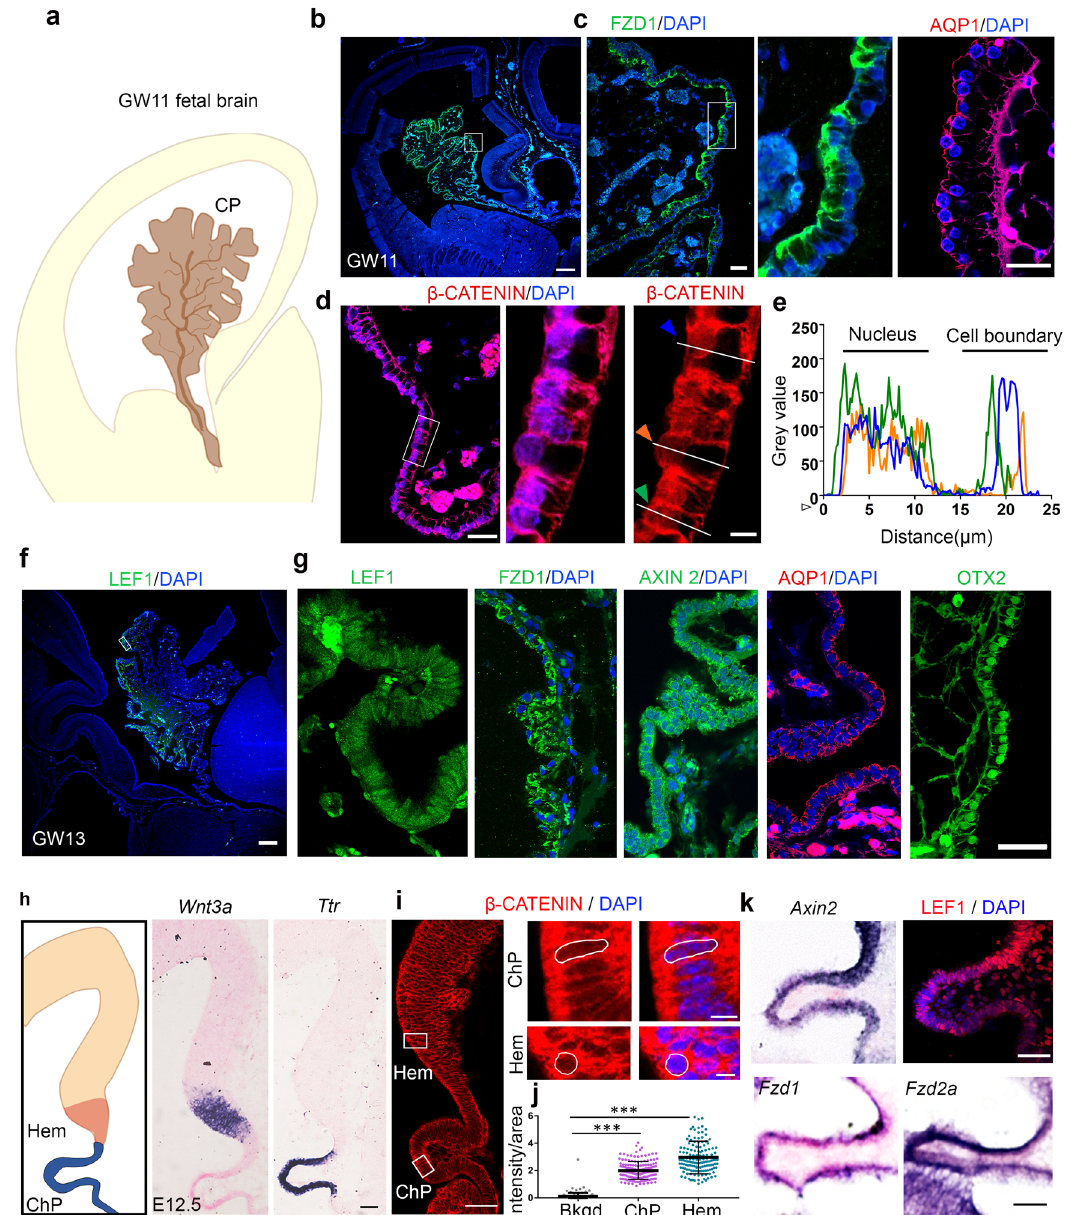
Fig. 1 Canonical Wnt signaling components are present in the developing human and mouse choroid plexus epithelium. a – g Canonical Wnt signaling pathway molecules FZD1, β -CATENIN, LEF1, and AXIN2, and also ChPe markers OTX2 and AQP1 are detected at gestational week (GW) 11 ( b – e ) and GW13 ( f , g ) in the human choroid plexus epithelium. d , e β -CATENIN immunohistochemistry intensity measurements across three ChPe cells (identi fi ed by colored arrowheads in d corresponding to traces in e ). β -CATENIN intensity is seen in the nucleus, indicative of active canonical Wnt signaling and the boundaries between cells. b – g Representative images of sections taken from 1 fetal brain at each age. h In the E12.5 mouse telencephalon, Wnt3a and Ttr expression identi fi es the hem the ChPe, respectively. i , j Nuclear localization of β -CATENIN and its quantitation (Bkgd, background; scatterplot represents mean ± SEM; n = 150 nuclei; N = 3 brains (biologically independent replicates) examined over 3 independent experiments. k Canonical Wnt signaling components Axin2, Fzd1, Fzd2a , and LEF1 are expressed in the E12.5 mouse ChPe. ( h , k ) Representative images of sections taken from N = 7 brains (biologically independent replicates) examined in 5 independent experiments. Statistical test ( j ): One Way ANOVA followed by post hoc Dunnett ’ s multiple comparison test ( p < 0.0001), * p < 0.05, ** p < 0.01, *** p < 0.001, ns if p value > 0.05. Scale bars: 500 μ m (all panels in b and f ); 50 μ m (all panels in d , i low mag, g , h , and k ); 10 μ m ( d and i high mag). Boxed regions ( b , c , d , f , i ) are shown at high magni fi cation in the adjacent panels. Further information on replicates and reproducibility for this fi gure is mentioned in the “ Statistics and Reproducibility ” section of the Methods. Source data are provided as a Source Data fi le.